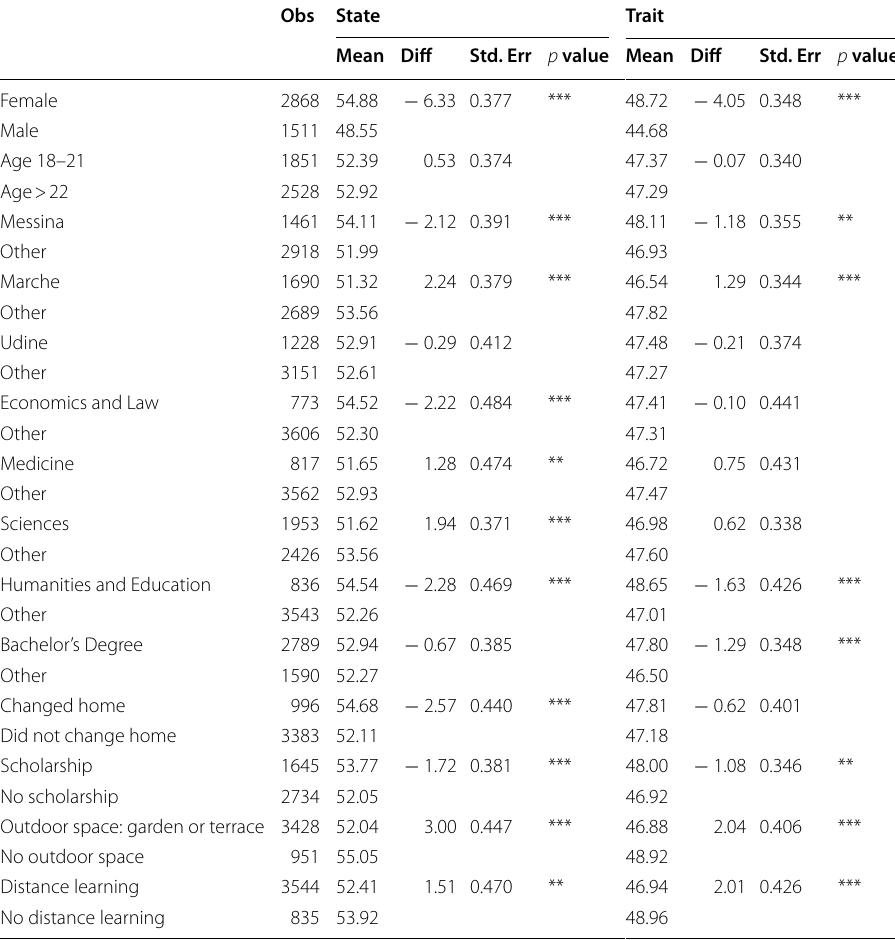
Table 6 Difference in means for the employed variables ( t test)—state and trait